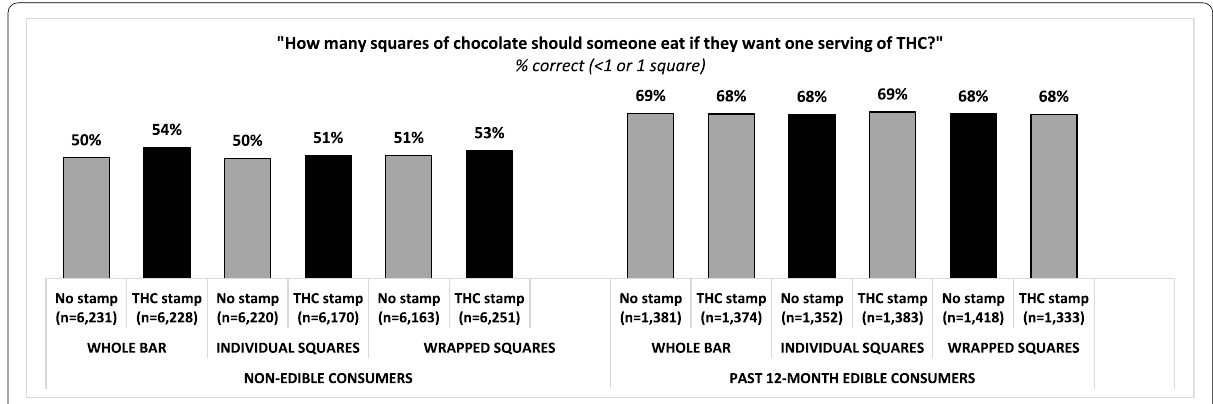
Fig. 2 Accuracy in identifying THC servings displayed on cannabis edible packaging by experimental question ( n correctly to question, “How many squares of chocolate should someone eat if they want one serving of THC?” (correct response